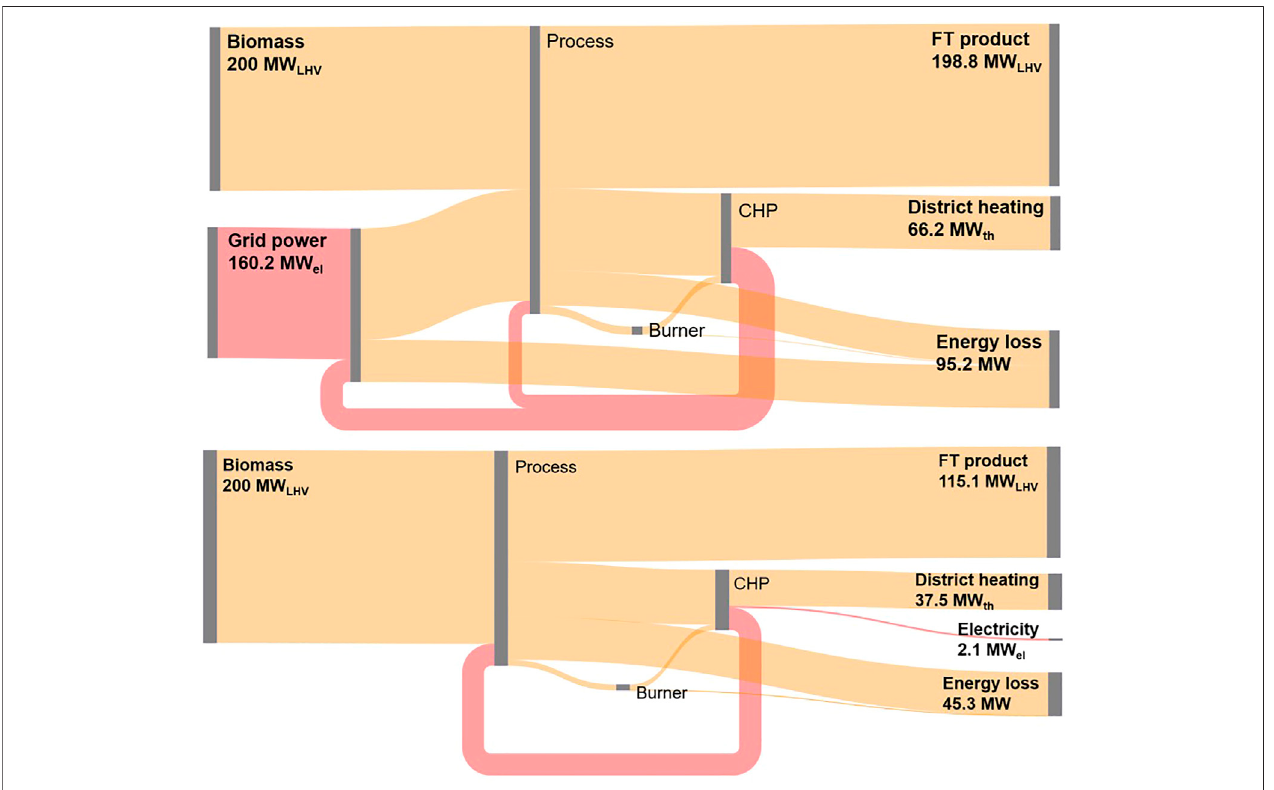
FIGURE 5 | Energy fl ow Sankey diagram for case 1.1 BA mode (top) , EA mode (bottom) (chemical or thermal power in orange, electrical power in red).